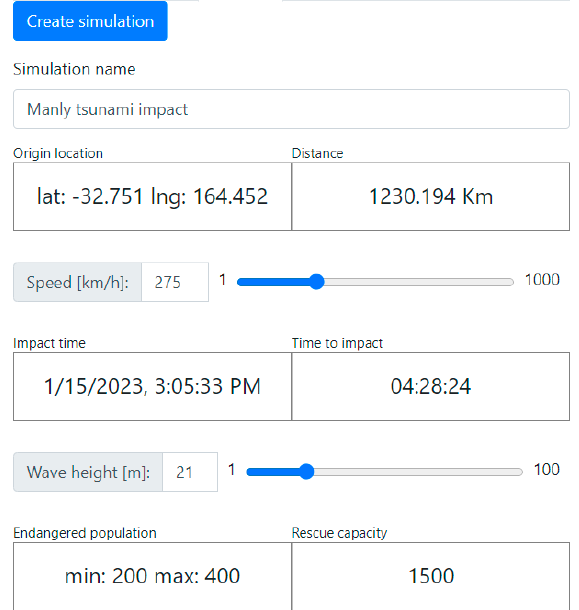
Figure 3. The figure shows the tsunami wave parameter setting screen that is used to estimate the impact of the tsunami. The user can use the sliders to change the calculated values from the CFD cloud component, such as speed and wave height. In reference to the tsunami origin, the application recalculates the impact time and time-to-impact fields. The endangered people are also recalculated based on the location definitions and the wave height.